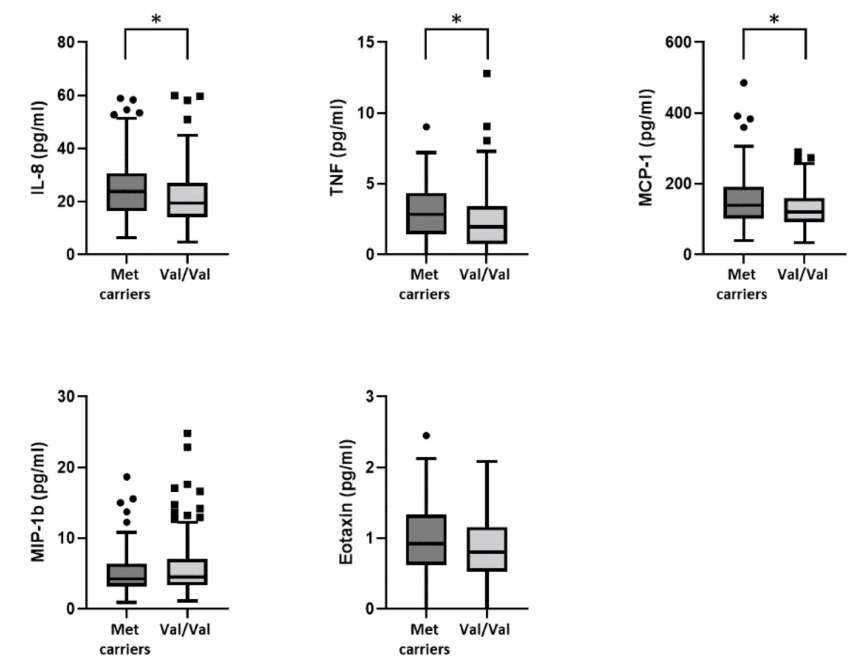
Figure 2. Association between BDNF Val66Met polymorphism and the CSF levels of TNF, IL-8, MCP-1, Eotaxin, and MIP-1b. Figure 2 legend: CSF (cerebrospinal fluid); IL (interleukin); MCP-1 (monocyte chemoattractant protein-1); MIP-1b (macrophage inflammatory protein 1b); TNF (tumor necrosis factor). (*) denotes statistical significance ( p <